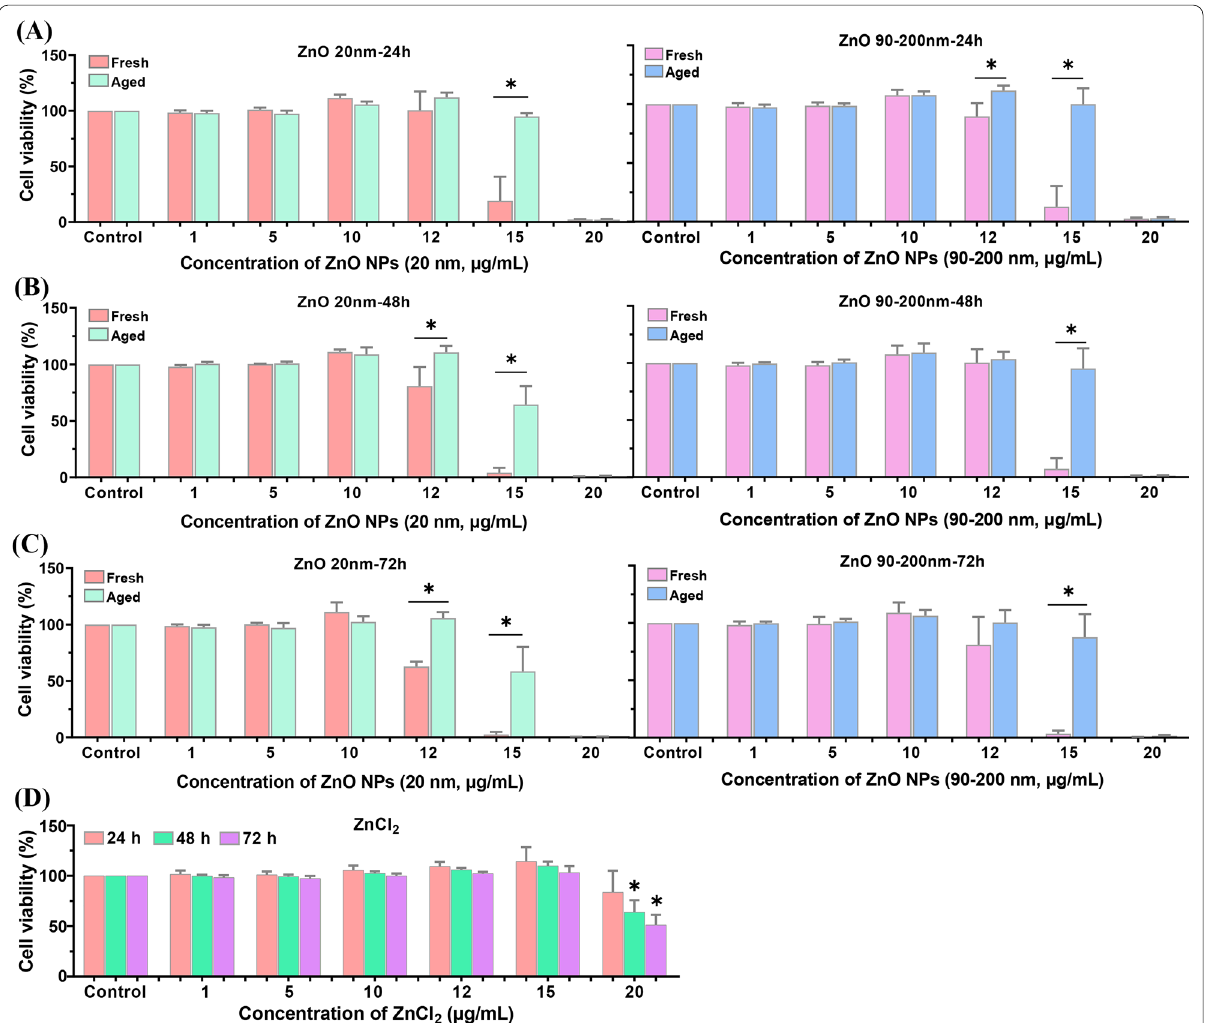
Fig. 3 Cell viability induced by fresh and aged ZnO NPs in A L cells. A L cells were incubated with various concentrations of fresh and aged ZnO NPs (20 and 90–200 nm) for 24 h ( A ), 48 h ( B ) and 72 h ( C ). D A L cells were exposed to various concentrations of ZnCl 2 for different times. Data were based on 3 independent experiments and expressed as mean ≥